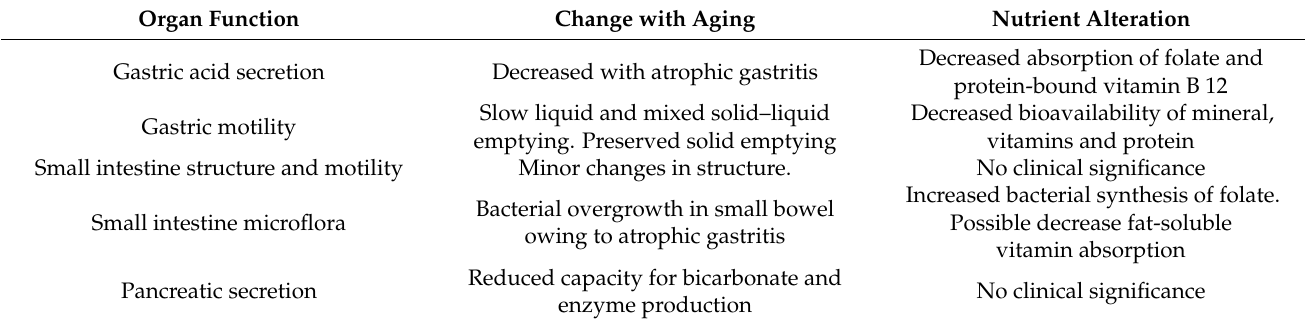
Table 2. Changes with aging in gastrointestinal organ function and resulting alterations of nutrient status. Organ Function Change with Aging Nutrient Alteration Decreased absorption of folate and Gastric acid secretion Decreased with atrophic gastritis protein-bound vitamin B 12 Slow liquid and mixed solid–liquid Decreased bioavailability of mineral, Gastric motility emptying. Preserved solid emptying vitamins and protein Small intestine structure and motility Minor changes in structure. No clinical significance Increased bacterial synthesis of folate. Bacterial overgrowth in small bowel Small intestine microflora Possible decrease owing to atrophic gastritis